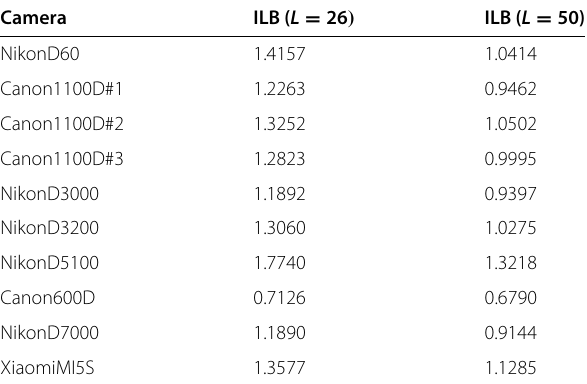
Table 3 Lower bound (6) in bits per pixel for different cameras and sizes of estimation sets when the BM3D denoising algorithm is